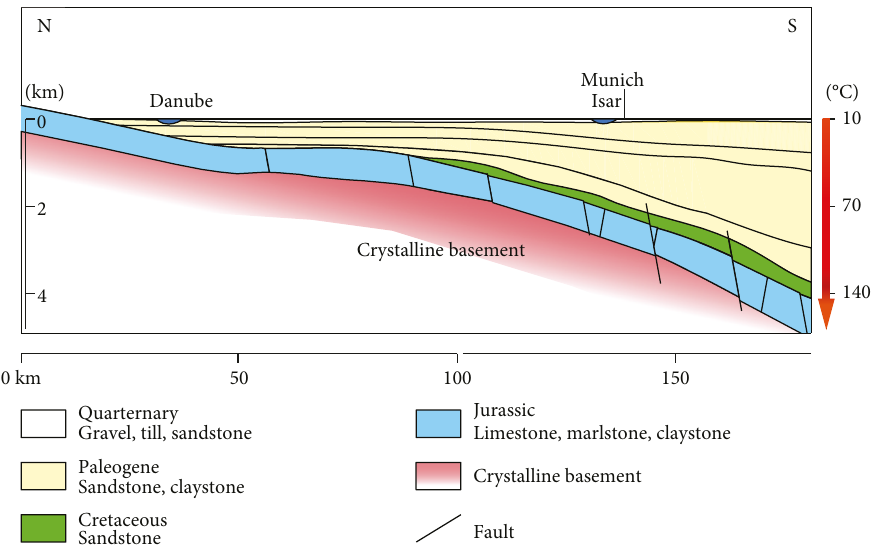
Figure 2: Cross section of the Molasse Basin in southern